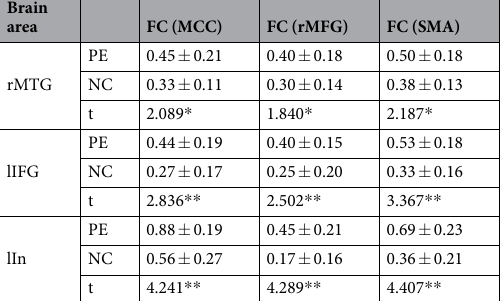
Table 2. Functional connectivity value of three areas in premature ejaculation patients and healthy controls. The data from each group are presented in terms of the mean score (Mean) and standard deviation (SD) in the PE and NC groups. MCC: middle cingulate cortex; rMFG: right middle frontal gyrus; SMA: supplementary motor area; rMTG: right middle temporal gyrus; lIFG: left inferior frontal gyrus; lIn: left insula; FC = Functional connectivity; * p < 0.05; ** p < 0.01.